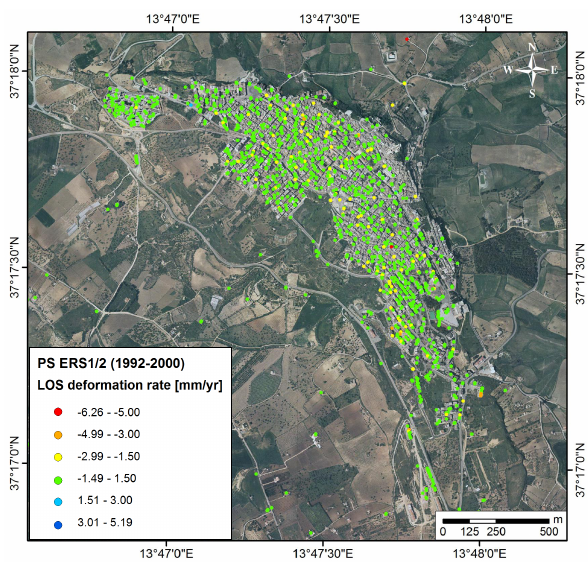
Fig. 6. PS ground deformation rates in the town of Naro in 1992–2000, measured along the LOS of ERS1/2 satellites in descending acquisition mode (see also Fig. 5a). Negative deformation values indicate movement toward the satellite. Positive values indicate movement away from the satellite.